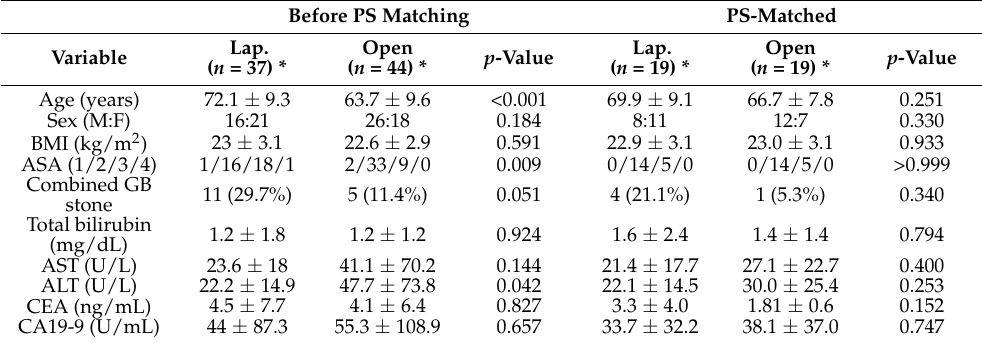
Table 3. Surgical outcomes of the patients.